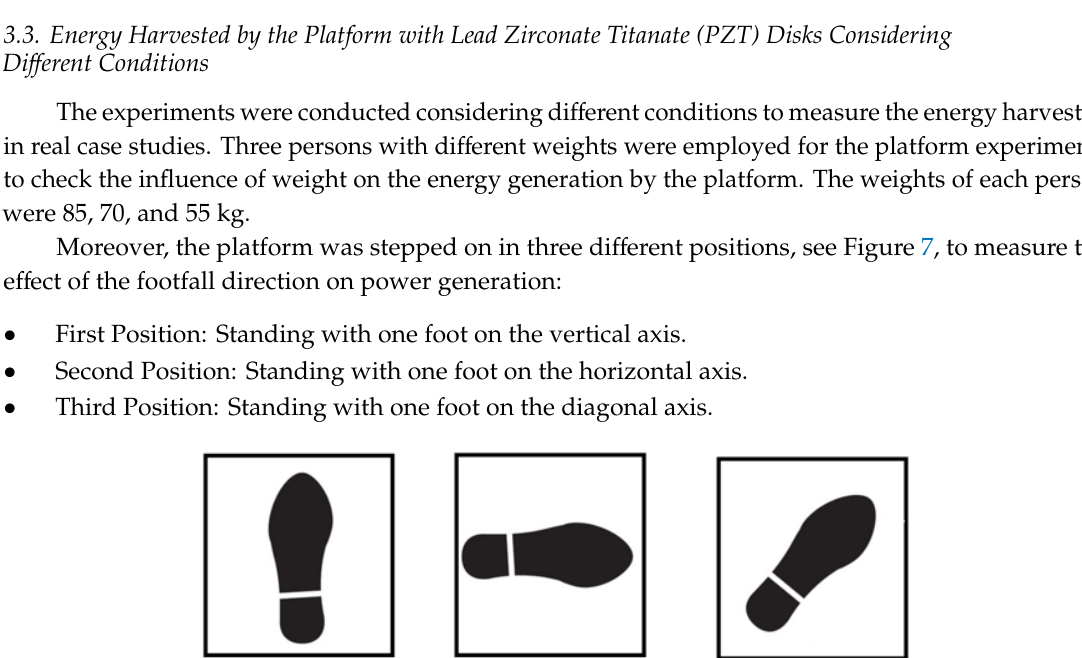
Figure 6. Voltage of each piezoelectric in a row along a footprint.